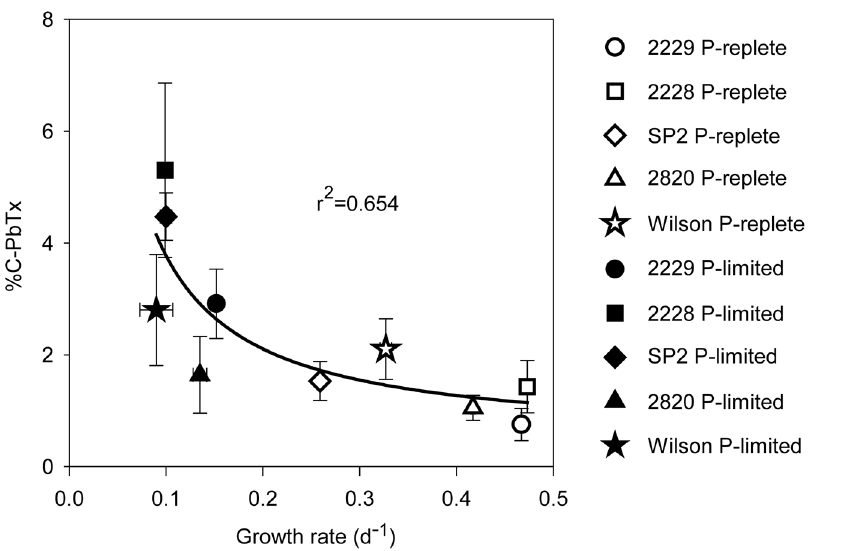
Figure 7. Relationship between cellular brevetoxins expressed as a percent of cell carbon (%C-PbTx) and specific growth rate (d -1 ). Results from P-replete and P-limited cultures are indicated by open and filled symbols, respectively. Error bars indicate standard deviations of triplicate measurements of brevetoxins and duplicate measurements of cell carbon. The best fit curve for the data was obtained using the iterative SigmaPlot H 11.2 graphical analysis program.